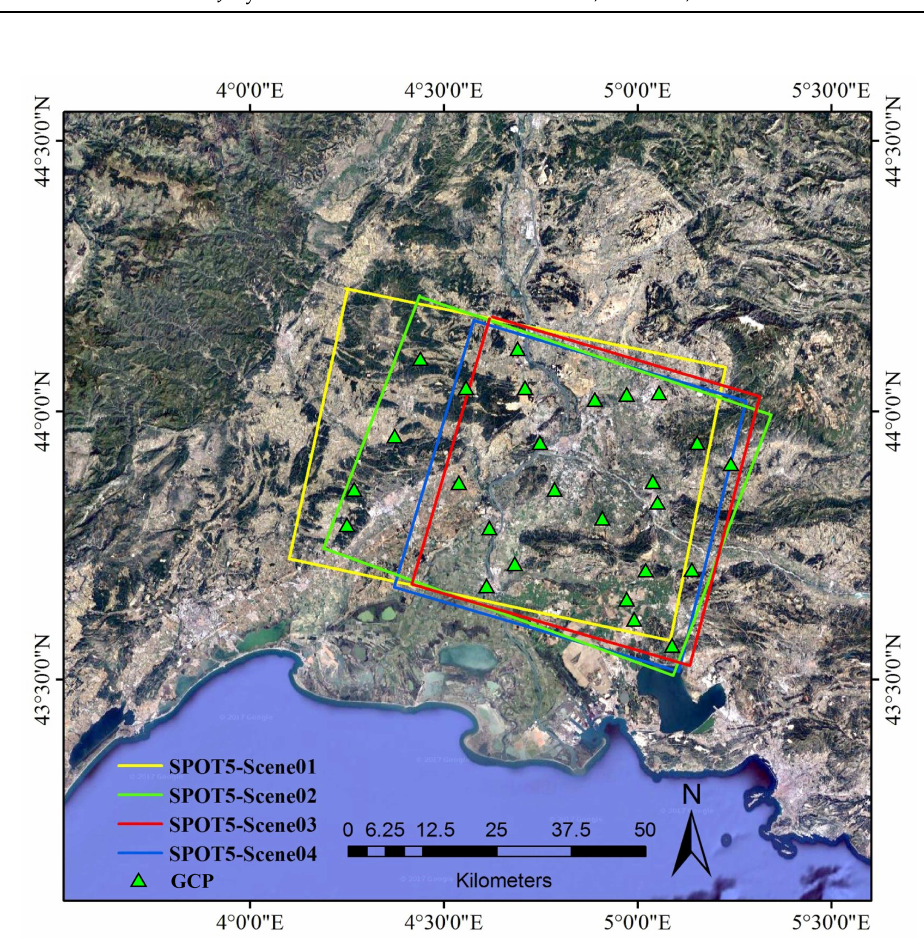
Figure 2. The extents of 4 SPOT-5 images in France and the GCPs distribution (The background map is downloaded from the Google